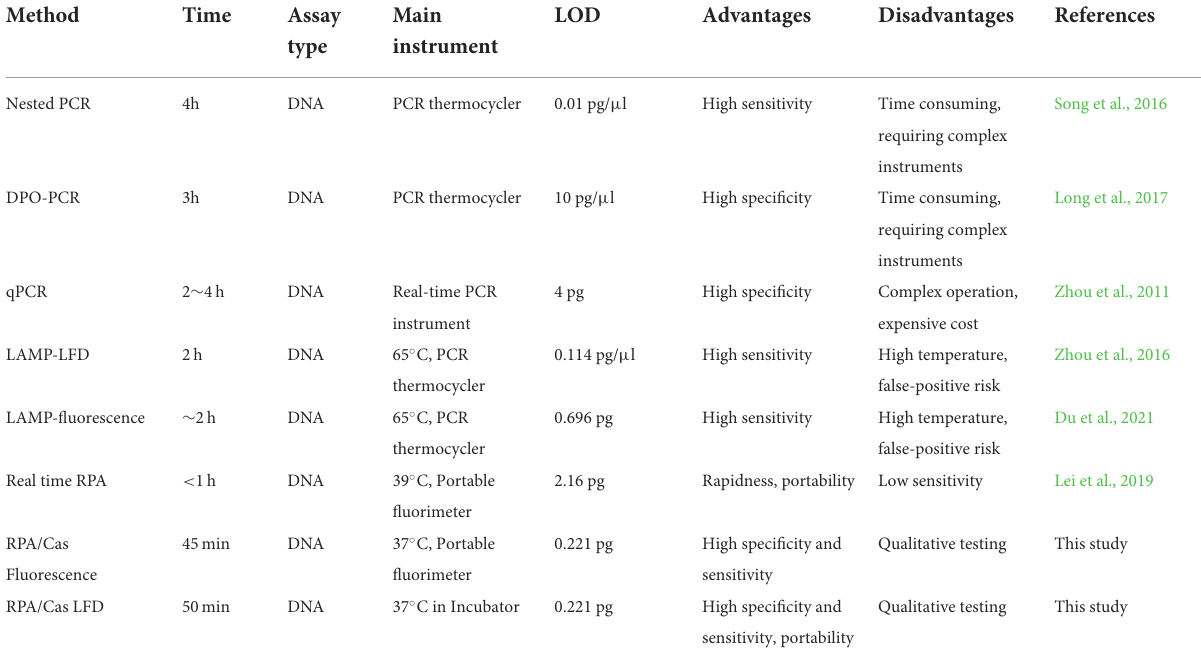
TABLE 2 Comparison of different detection methods for L. maculans